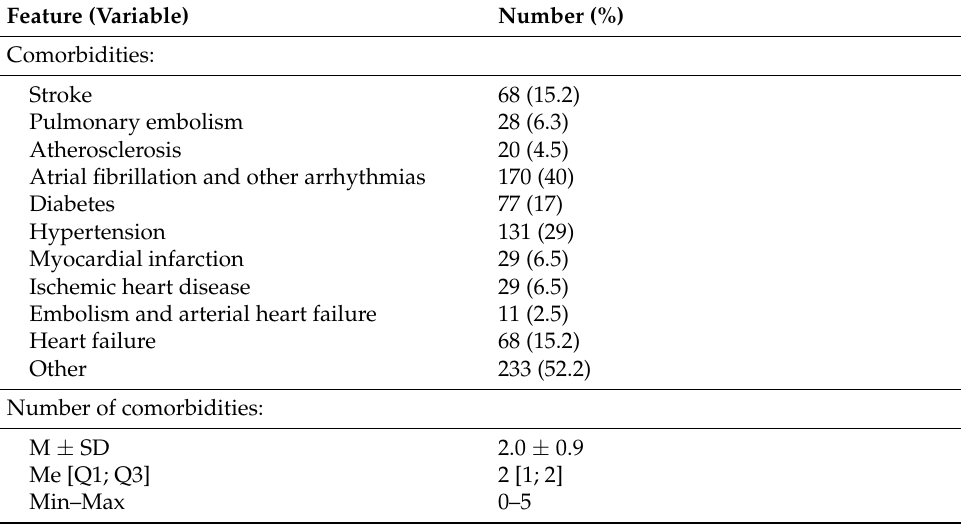
Table 2. Characteristics of comorbidities in the study